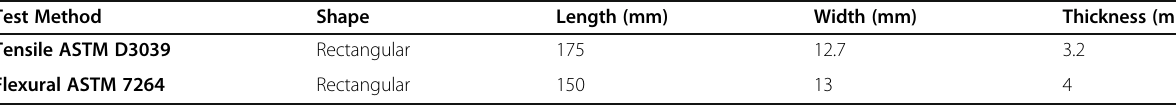
Table 3 Tensile and Flexural Test Sample Specifications